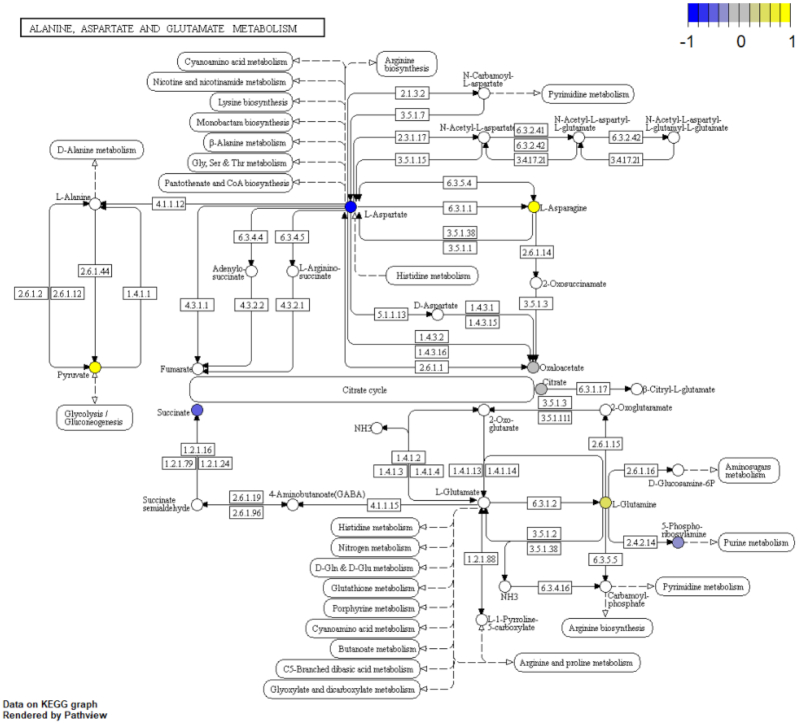
Pathway visualization: alanine aspartate and glutamate metabolism pathway. Color scheme is based on log2-transformed ratio of the mean values of ER− samples over ER+ samples. The pathway rendering was done by the Pathview R package.